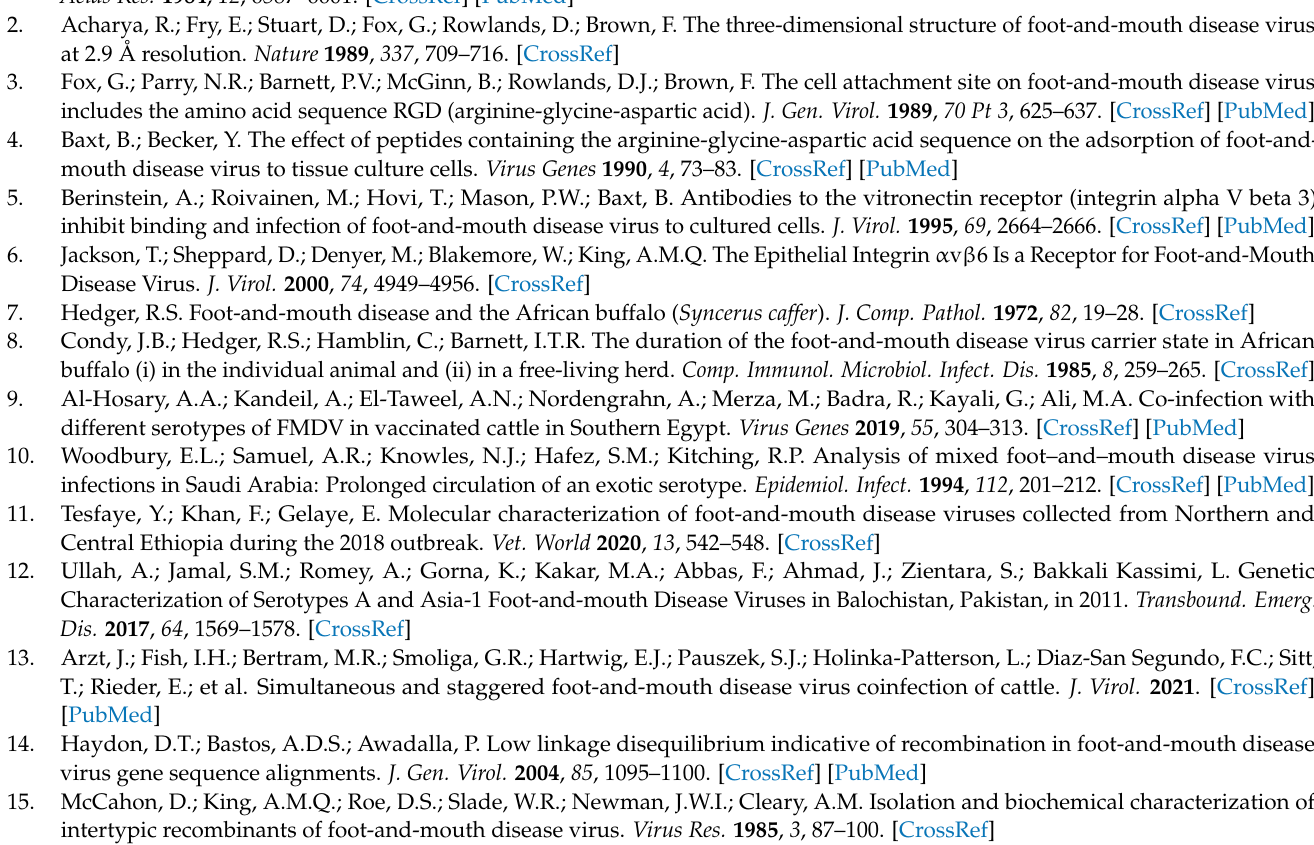
for 6 h. Figure S2: Growth comparison of HA-tagged and non-tagged Asia1/O1K FMDV. Table S1: Co-infection of goat epithelium cells with HA- and FLAG-tagged FMDV O1K/O